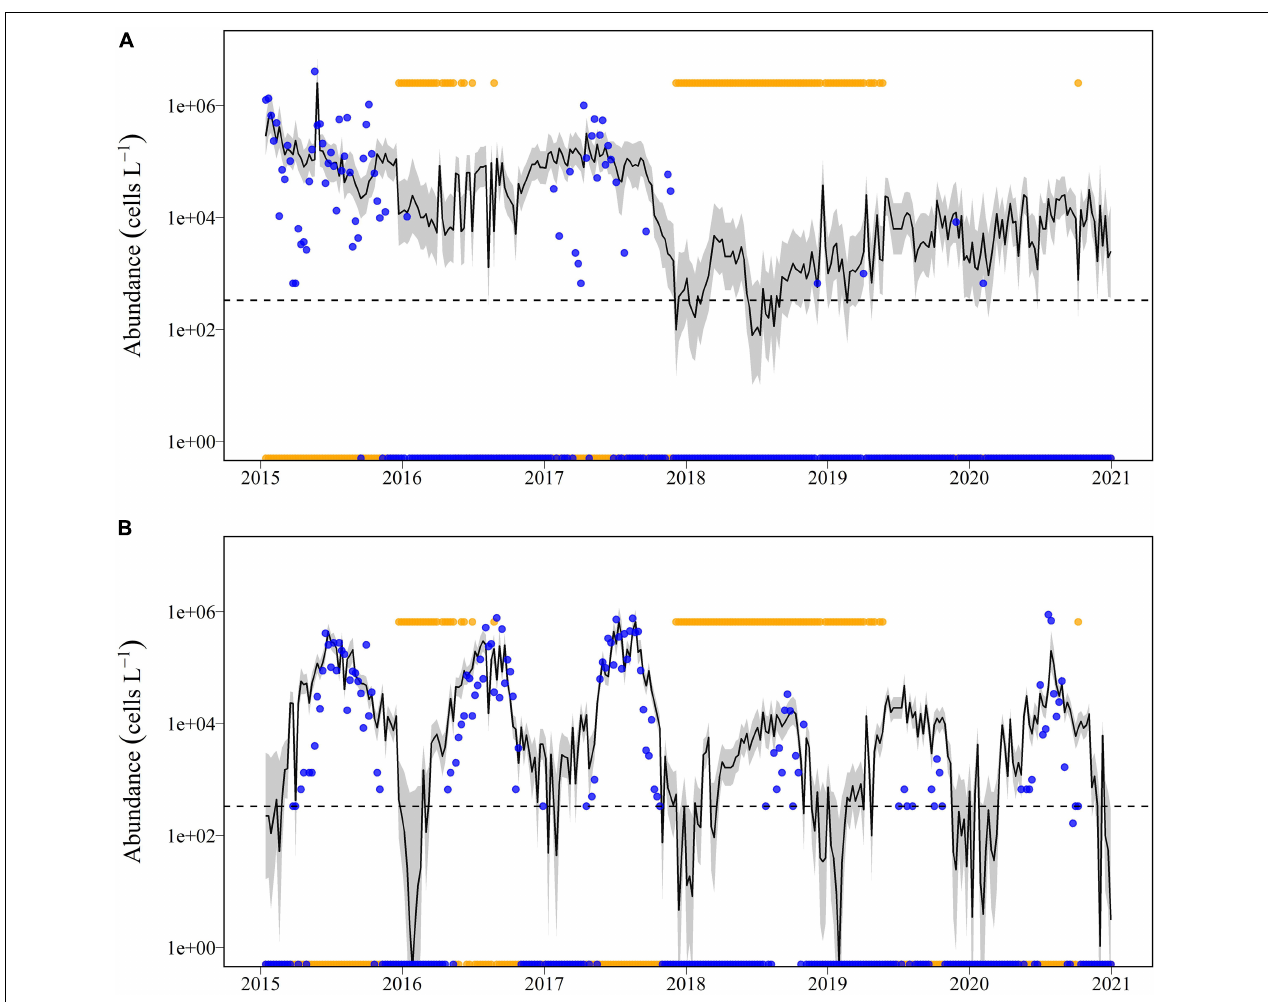
FIGURE 9 | Model-averaged predictions of abundance (solid black line) of (A) Pseudo - nitzschia spp. and (B) P. bahamense at the Diamond Bay station for the years 2016–2020, based on the best approximating models from negative binomial regression analysis compared to observed abundances (blue dots). The gray shaded area representing the 95% confidence interval. The dashed line indicates the microscopy detection limit of 333 cells L − 1 for these two taxa. The elevated horizontal yellow dots indicate the presence of A. lagunensis at bloom levels (i.e., above 2 × 10 8 cells L − 1